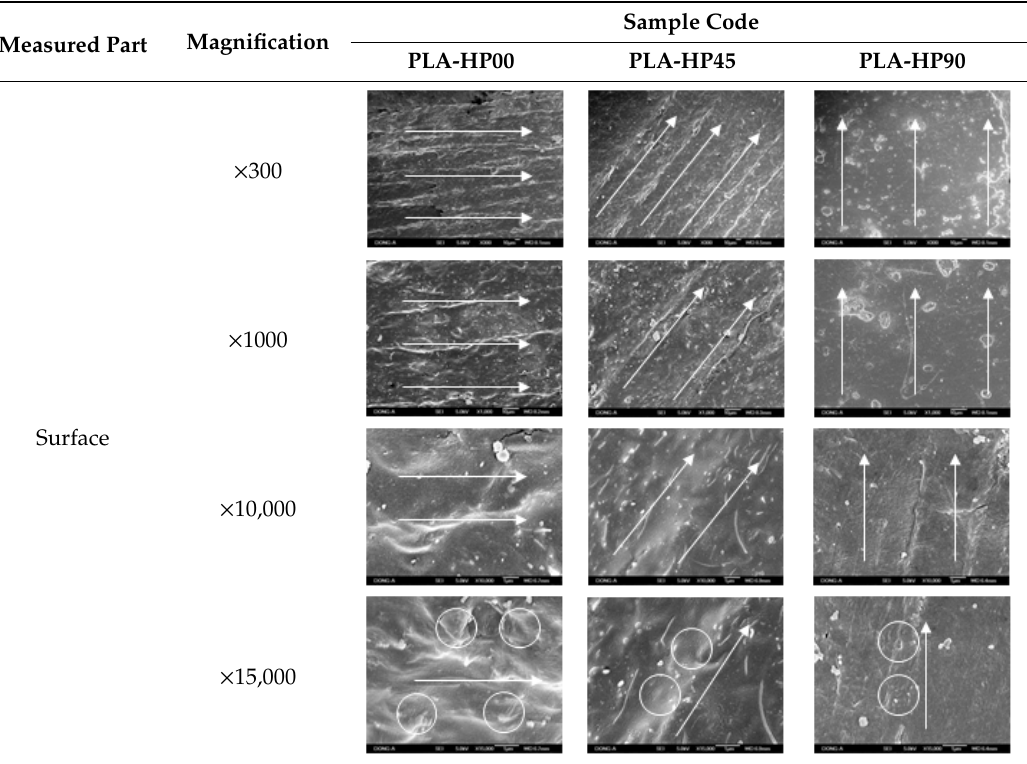
Table 5. Morphology of CFDM 3D-printed horseshoe pattern with different 3D printing directions.